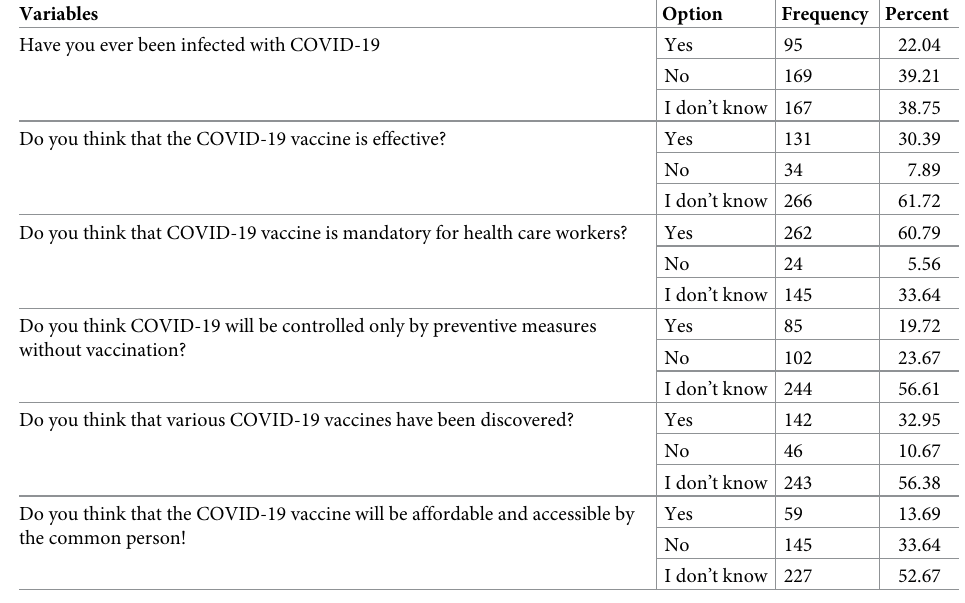
Table 3. Perception the health care professionals towards COVID-19 vaccine.